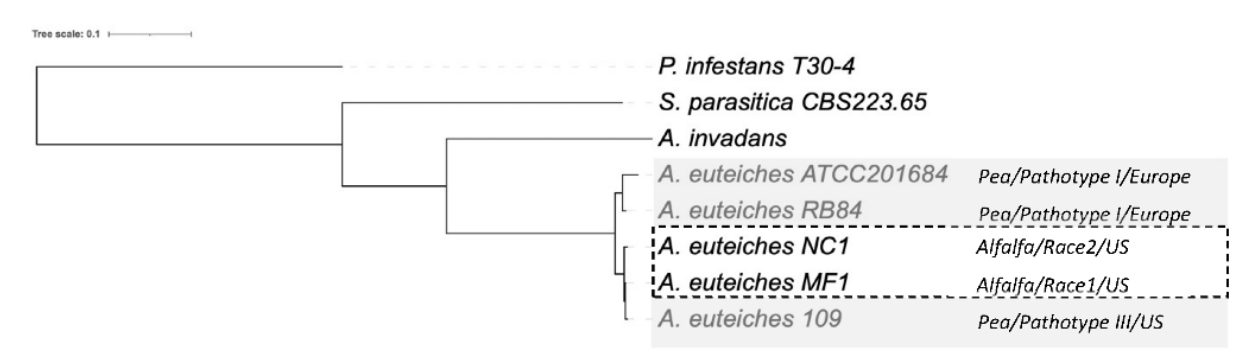
Figure 7. Phylogenetic relationship between the six sequenced A. euteiches strains. The maximum likelihood tree was built using Species Tree from All Genes (STAG) method from OrthoFinder. A. euteiches, S. parasitica and P. infestans were used as outgroups of different degrees of relativeness. MC1 and NC1 were identified as race 1 and race 2 (hatched square) based on their virulence on the Saranac and WAPH-1 alfalfa genotypes, while the ATCC201684, RB84 and Ae109 strains (grey square) were included in the ‘pathotype’ based on their aggressiveness against a pea collection. The geographical origins of the strains are indicated.